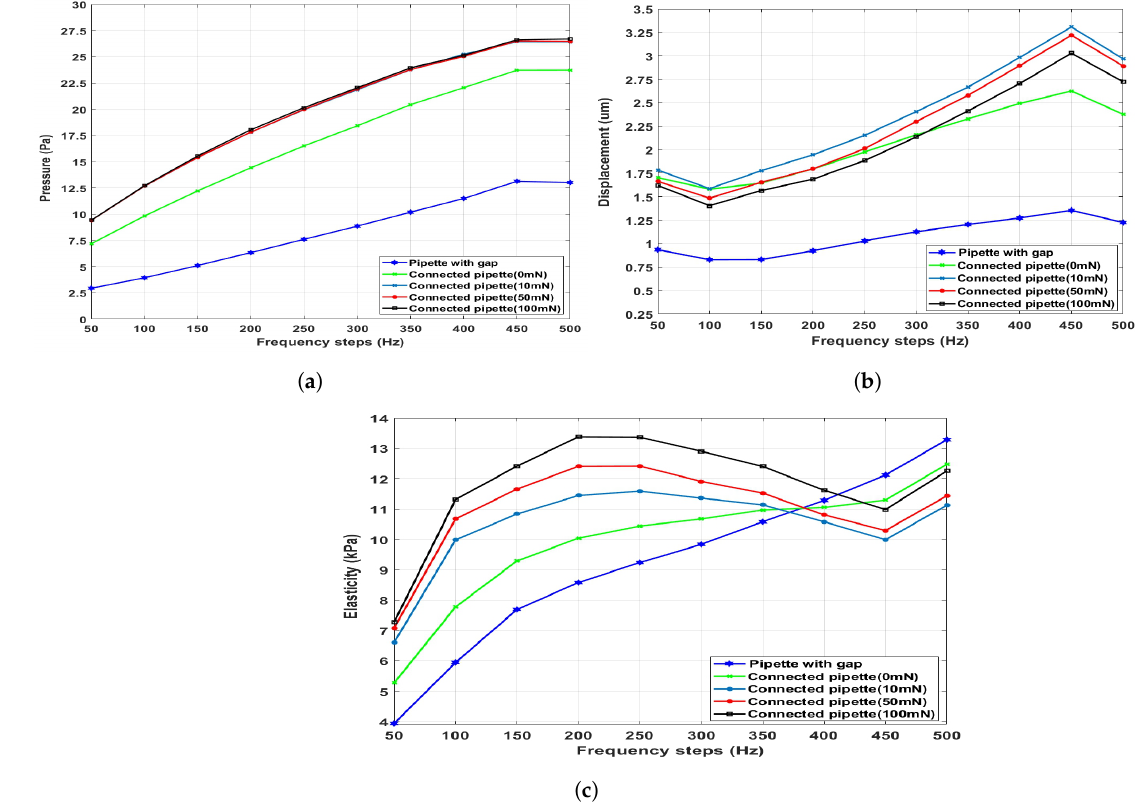
Figure 8. The measurement results in the two boundary conditions; ( a ) measured excitation pressure; ( b ) measured displacement amplitude; ( c ) calculated modulus of